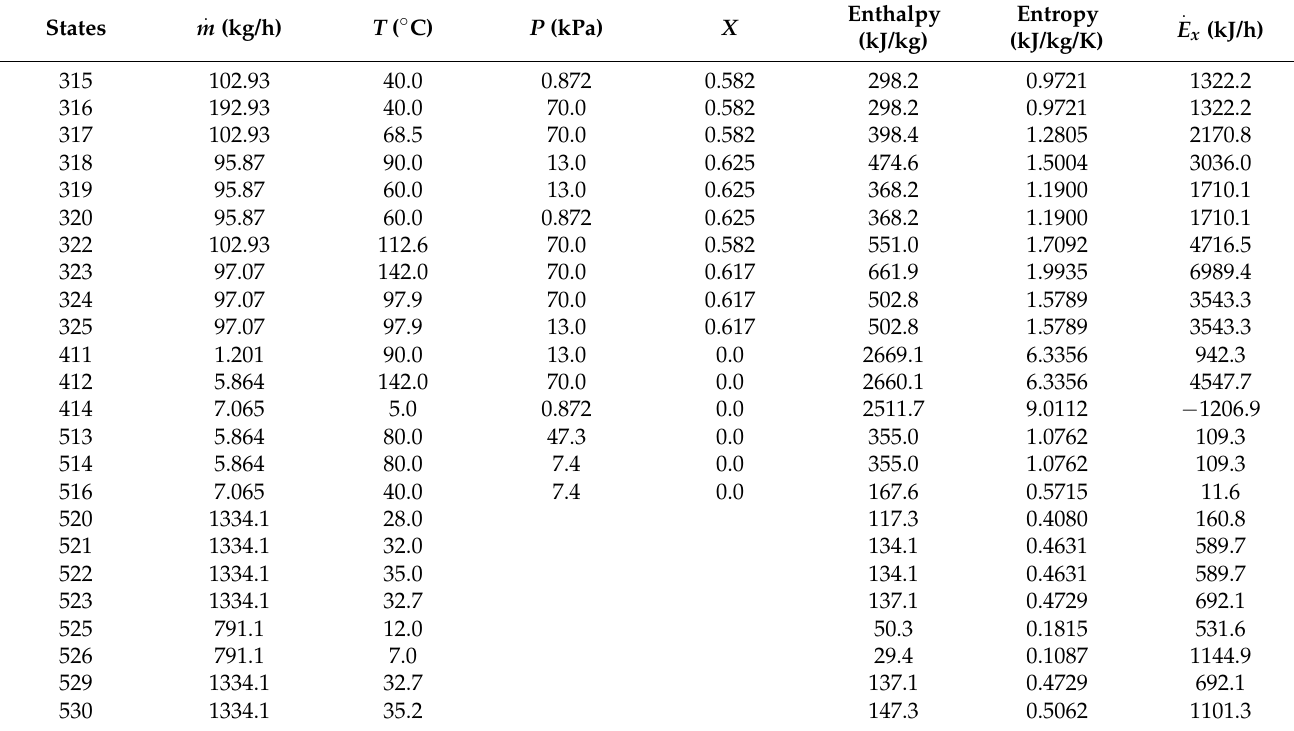
Table 10. Property values and mass and exergy flow rates at various state points in series